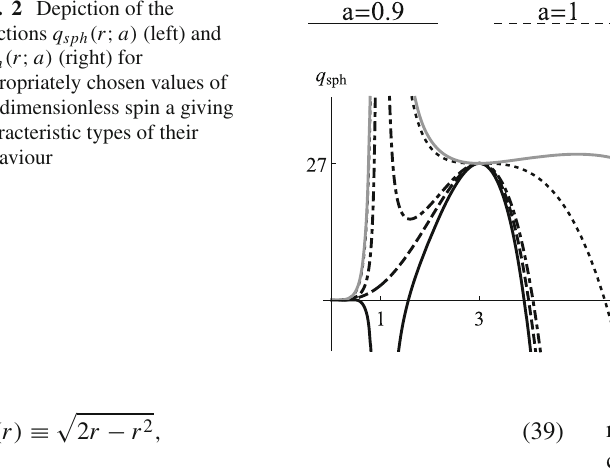
Fig. 2 Depiction of the functions q sph ( r ; a ) (left) and (cid:11) ( r ; a ) (right) for sph appropriately chosen values of the dimensionless spin a giving characteristic types of their